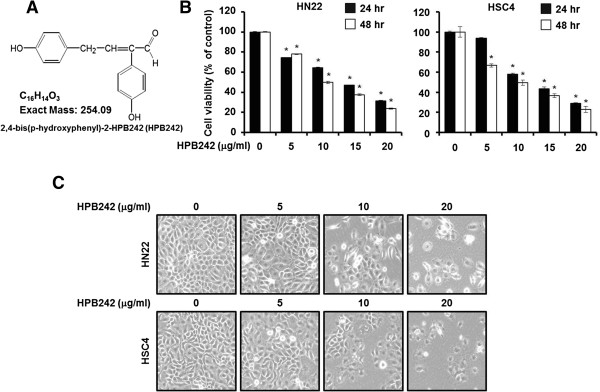
The effect of HPB242 on cell viability of oral cancer cells. (A) Chemical structure of HPB242. (B) The cell viability effect of HPB242 on HN22 and HSC4 cells. HN22 cells (2 × 103 cells/well) and HSC4 (3 × 103 cells/well) cells were seeded in 96-well plates and incubated for 24 hours and 48 hours with increasing concentrations of HPB242 in 10% FBS-DMEM. Cell viability was estimated using the trypan blue dye exclusion method, as described under Methods. Results are indicated as cell viability relative to the untreated HPB242, and data are represented as means ± SD from three independent experiments. The asterisk indicates a significant difference compared to the negative control (untreated cells) (*p < 0.05). (C) Morphological changes observed in the HPB242 treated (5, 10, and 20 μg/ml) or untreated HN22 and HSC4 cells 48 hours post-treatment.